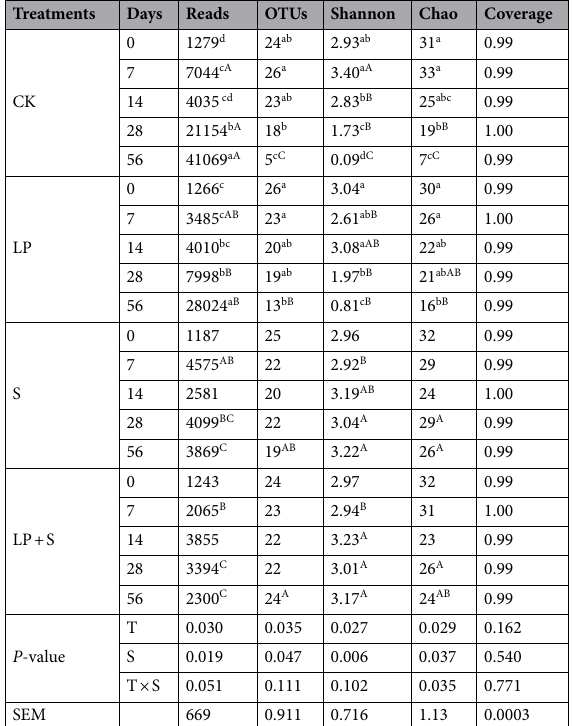
Table 5. Alpha diversity of clostridial community in alfalfa silage during ensiling. a–d Means within a column with different superscripts differ ( P < 0.05); A–E Means within a raw with different superscripts differ ( P < 0.05). CK, control; LP, Lactobacillus plantarum ; S, sucrose; LP + S, the addition of both sucrose and Lactobacillus plantarum ; T, effect of treatment; S, effect of storage period; T × S: interaction between treatment and storage period; SEM, standard error of